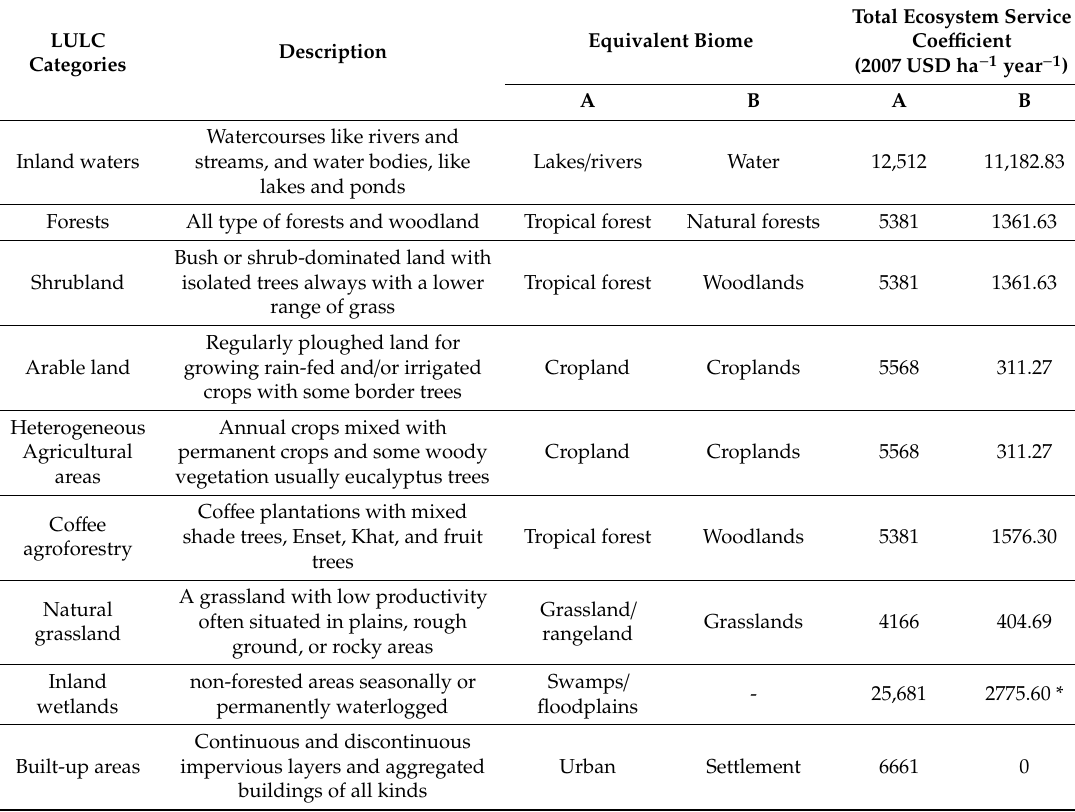
Table 1. LULC categories in ACB, the corresponding equivalent biomes, and ESV coe ffi cients obtained from Costanza et al. [12] (A) and Kindu et al. [21]